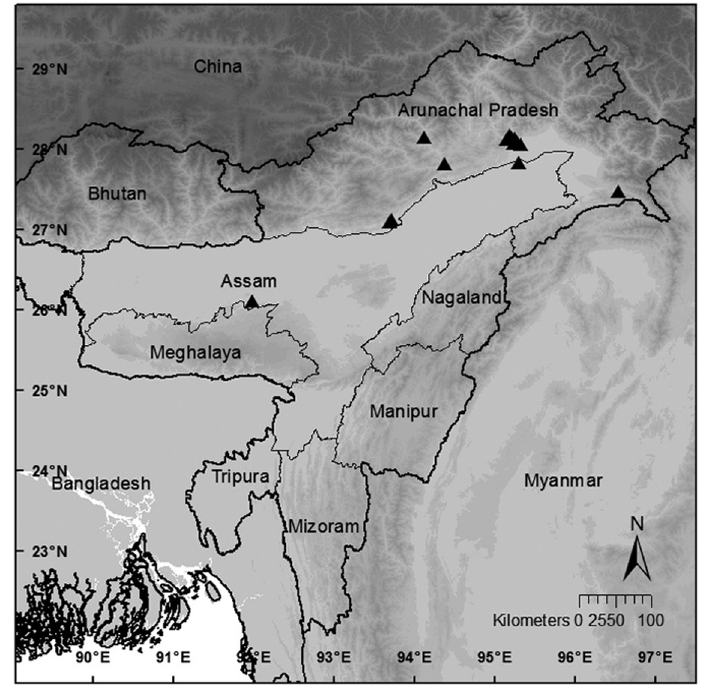
Fig. 16. Map showing the location of B. burkillii Dunn